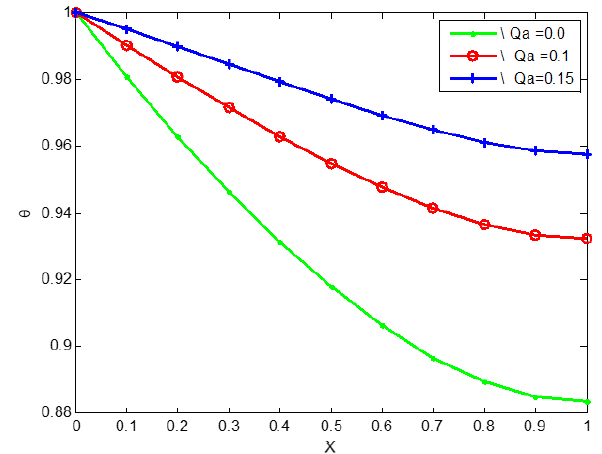
Figure 11. The effect of internal heat generation on the temperature distribution of a convex copper porous fins